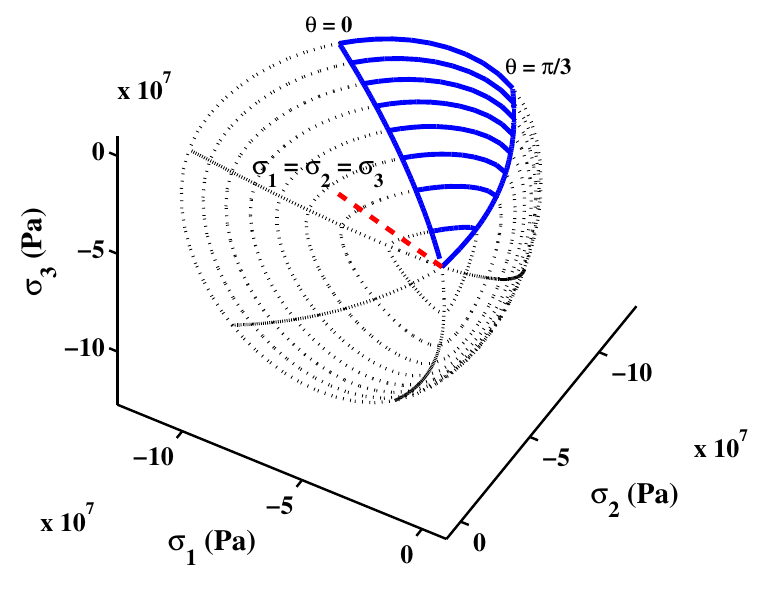
Figure 3. Deviatoric sections of triaxial